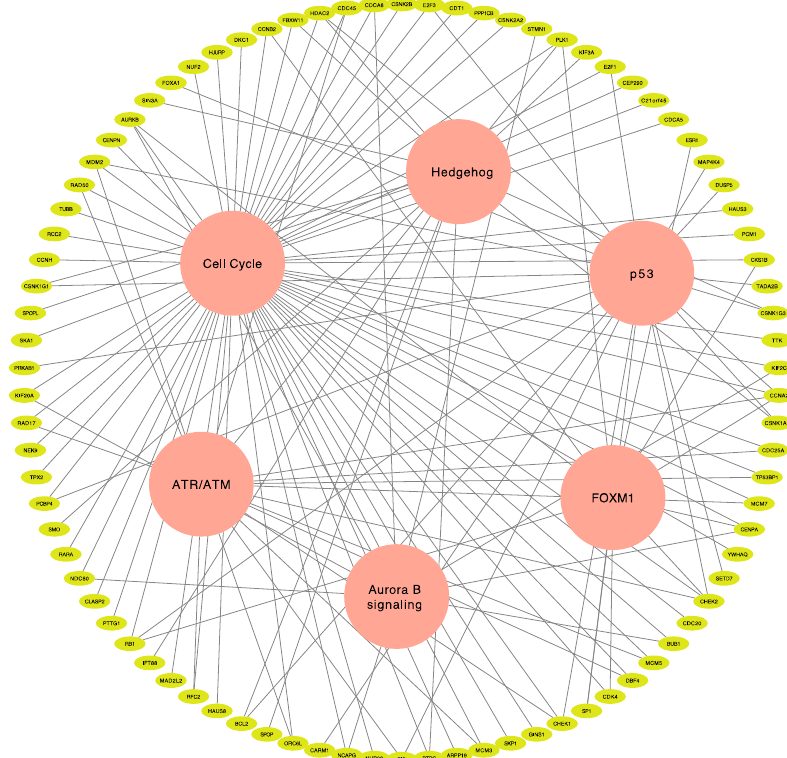
Figure 4. Putative target genes involved in multiple pathways of ESR1-CCDC170 fusion-positive cancer. Six major cancer signaling pathways associated with p53, ATR/ATM, FOXM1, hedgehog, cell cycle, and Aurora B in accordance with their respective genes were visualized. Potential gene candidates involved in these pathways were discerned.